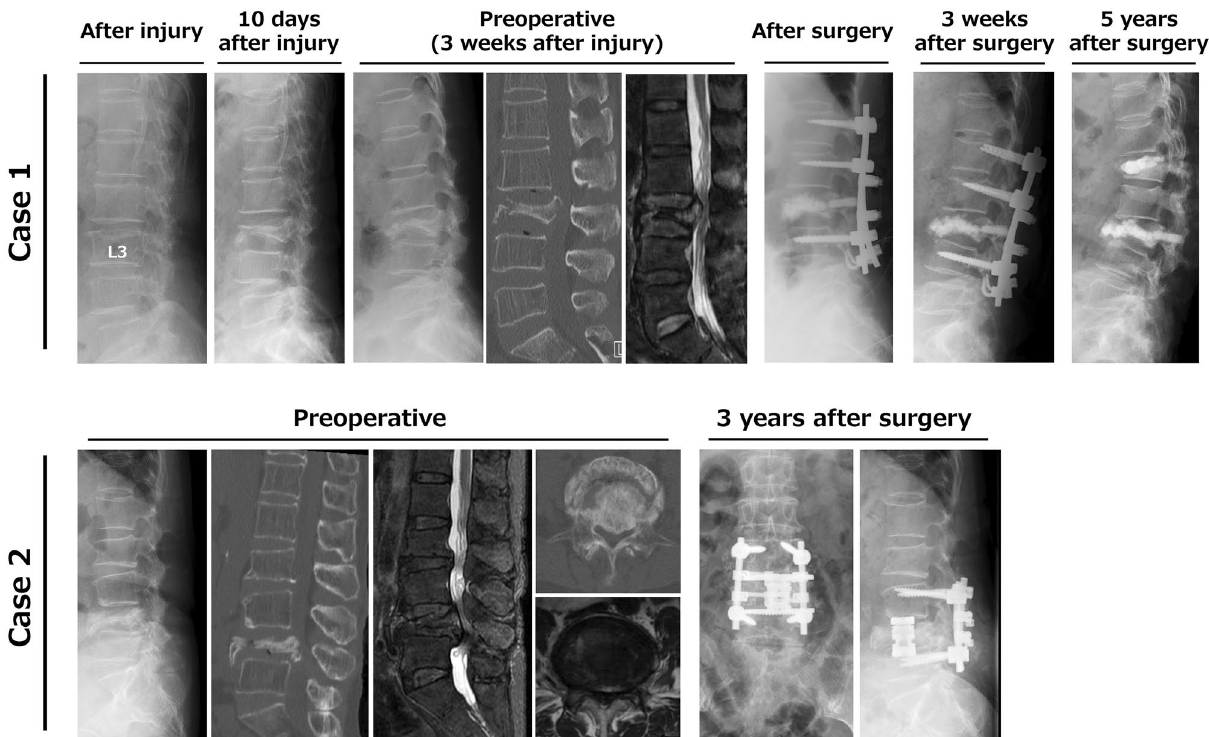
Figure 1. Case 1: A 74-year-old female (Hoehn & Yahr stage III) with severe low back pain and motor dysfunction due to rapidly progressive L3 osteoporotic collapse. Preoperative CT and T2-weighted MRI showed L3 collapse with canal stenosis by bony fragments that had retropulsed into the spinal canal. Instrumentation failure occurred early in the postoperative period with exacerbation of dyskinesia, and required removal of the pedicle screw, but daily activities were maintained despite a decrease in lumbar kyphosis at 5 years after surgery. Case 2: A 70-year-old female (Hoehn & Yahr stage II) with severe low back pain and motor dysfunction due to progressive L4 collapse. Preoperative CT and T2-weighted MRI showed L4 collapse with canal stenosis by bony fragments that had retropulsed into the spinal canal. The patient has been asymptomatic for 3 years after anterior reconstruction and pedicle screw